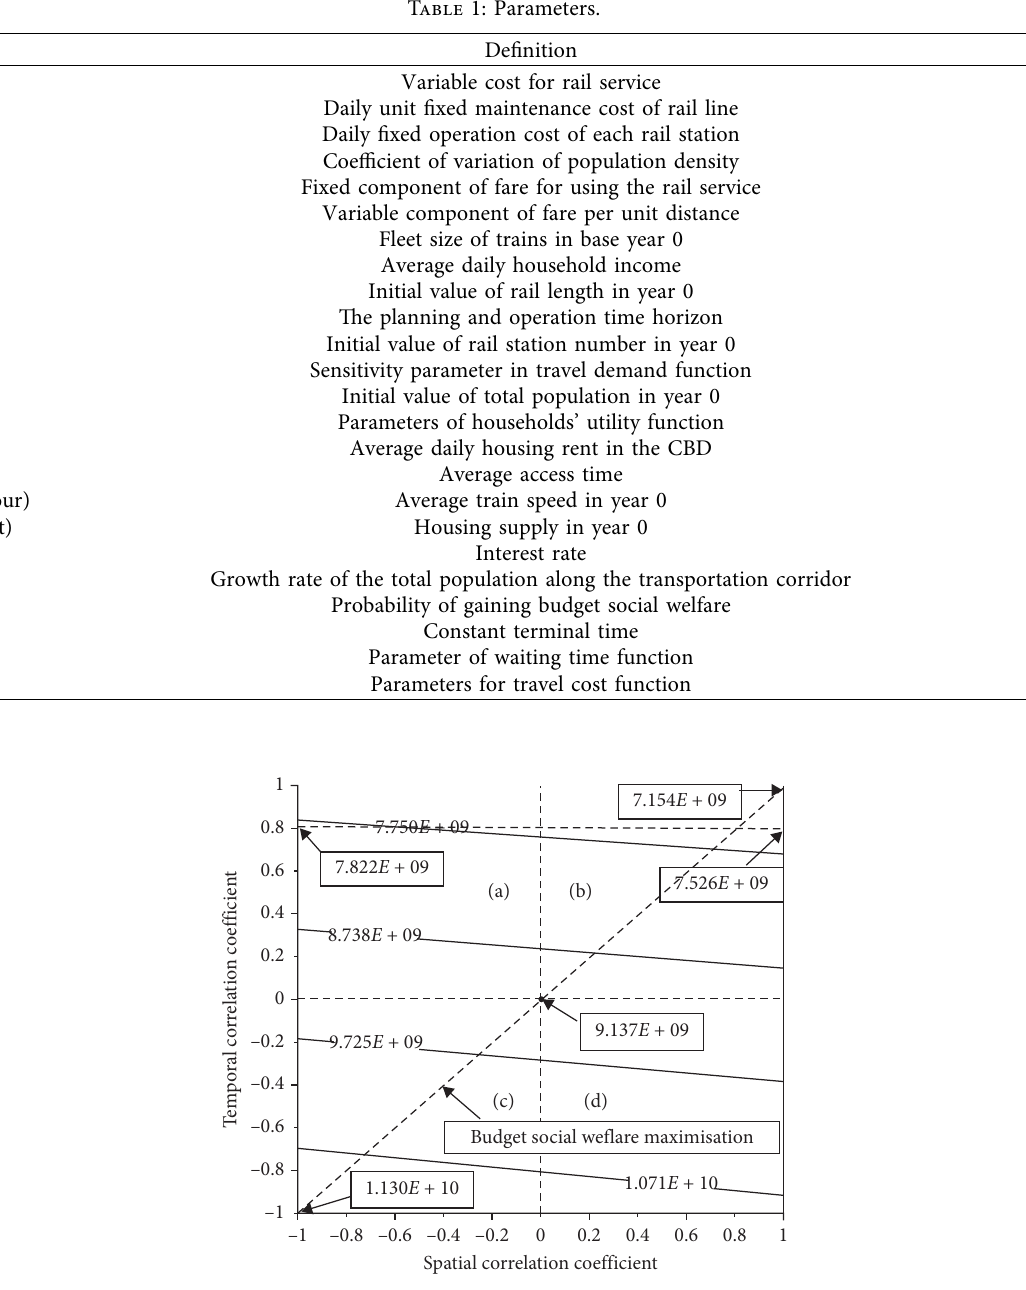
Figure 2: The effects of space-time correlation of population densities on social welfare